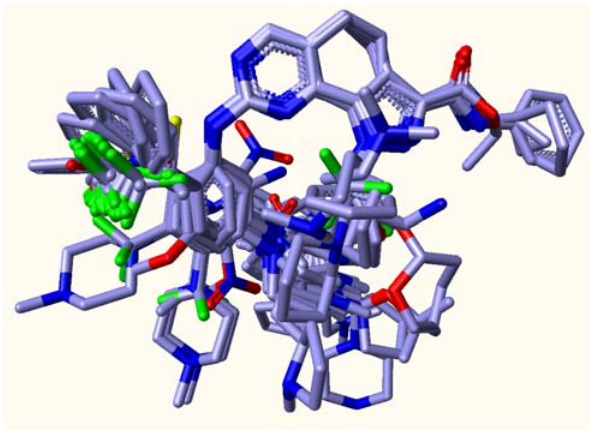
Figure 2. The common substructure based alignment.